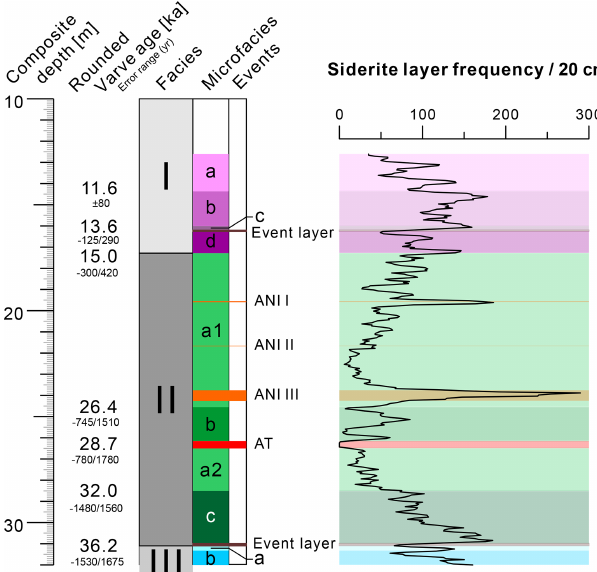
Figure 5. Sediment facies and microfacies zones in Lake Suigetsu Core SG06, ∼ 13–32m depth (simplified and supplemented from Schlolaut et al., 2018). Microscopy-based frequency of siderite lay- ers with quality level 1–3 (i.e., running average of layer counts per 20cm thick sediment section) serves as a measure of seasonal lamination quality and shows gradual transitions between varved and poorly varved sediment sections. Rounded varve ages are mi- croscopy based and constrain the age of major facies and microfa- cies boundaries. ANI I to ANI III mark core sections with ultrafine lamination due to sedimentation rate minima, AT marks the tephra layer named AT, “event layers” label major thin mud slides that are probably